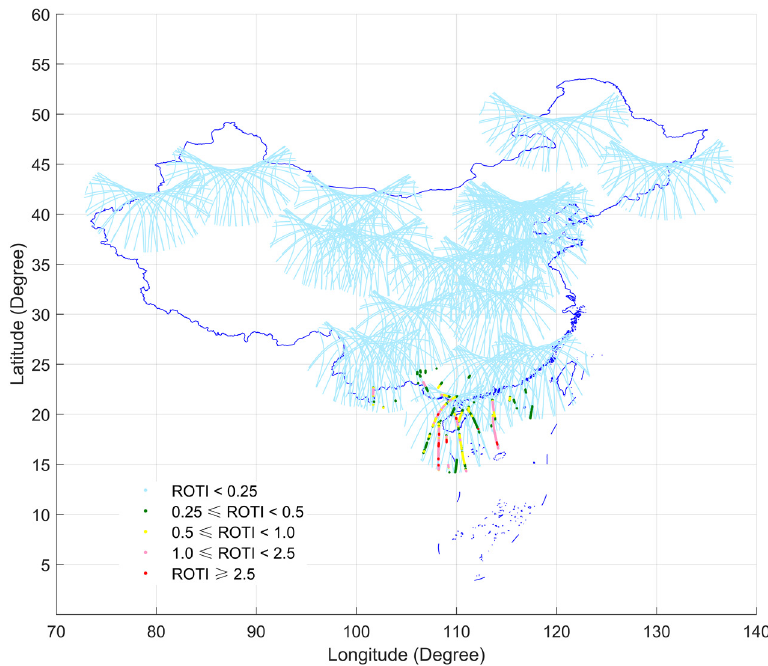
Figure 4. The spatial distribution of IPP according to the ROTI value for all of the observed GPS satellites from 20 sites across China (8 October 2003). The red point line refers to the IPP locations satisfying extremely strong TEC fluctuations ROTI ≥ 2.5; the pink point line refers to the IPP locations satisfying sub-strong TEC fluctuations 1.0 ≤ ROTI < 2.5; the yellow point line refers to the IPP locations satisfying moderate TEC fluctuations 0.5 ≤ ROTI < 1.0; the green point line refers to the IPP locations satisfying weak TEC fluctuations 0.25 ≤ ROTI < 0.5; and the light blue point line refers to the IPP locations satisfying no TEC fluctuations ROTI < 0.25.